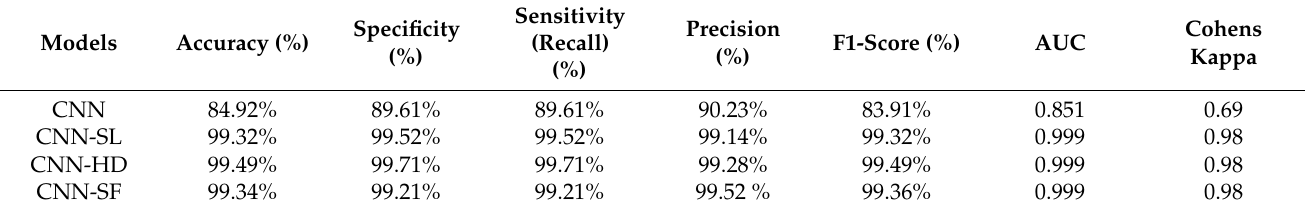
Table 3. Performance of CNN with